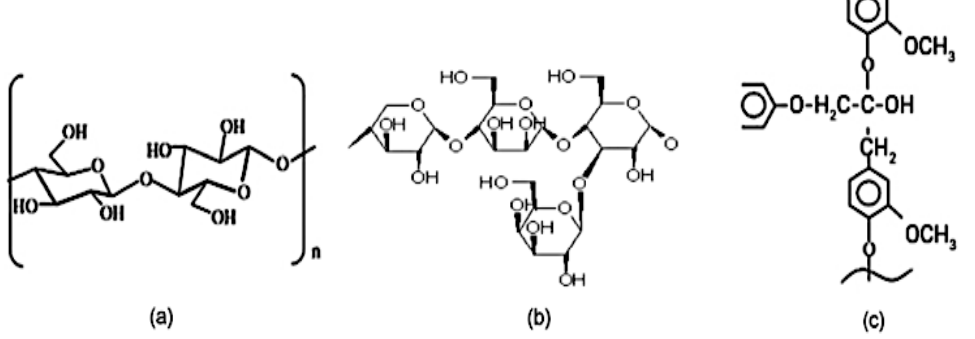
Figure 1. Chemical structures of the main components of natural fibres: ( a ) cellulose, ( b ) hemicellu- lose, and ( c ) lignin [46]. Table 2. Chemical compositions of different bast fibres